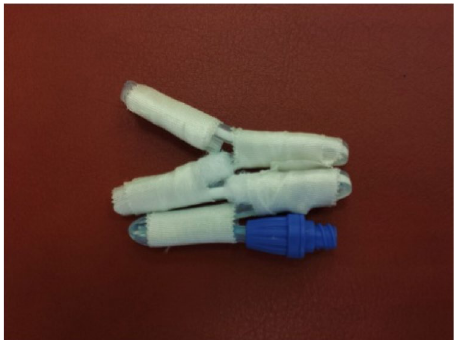
Figure 1. Static physical stress through multiple